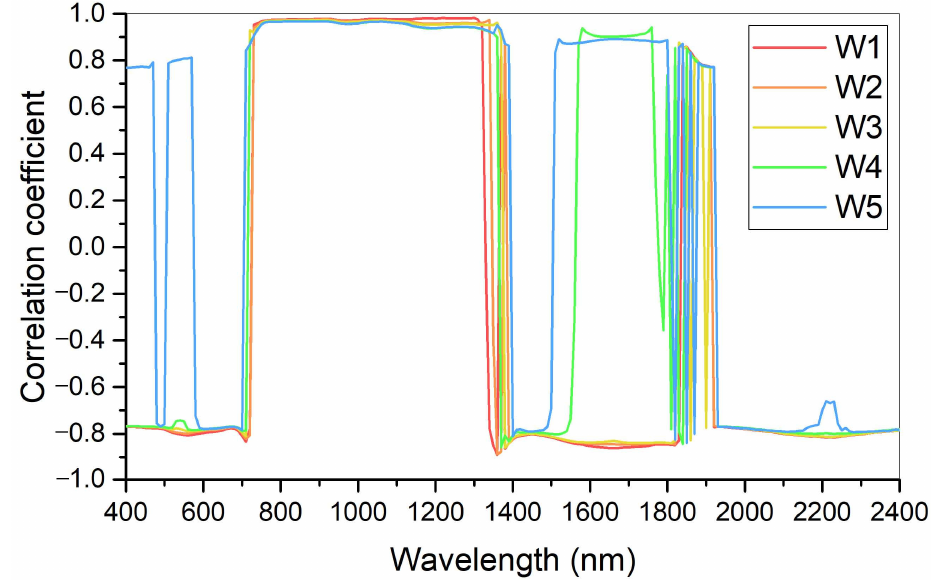
Figure 7. Correlation coefficient between different LAI and canopy spectral reflectance under continuous water stresses.